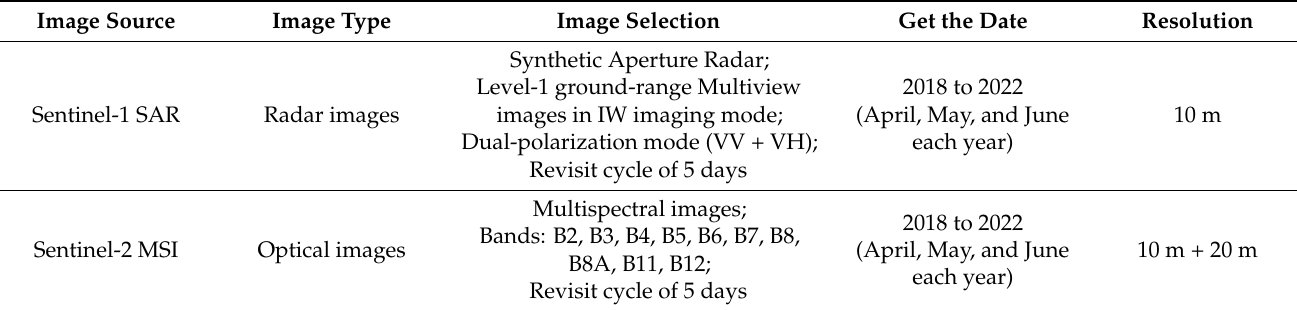
Table 1. Multi-source image